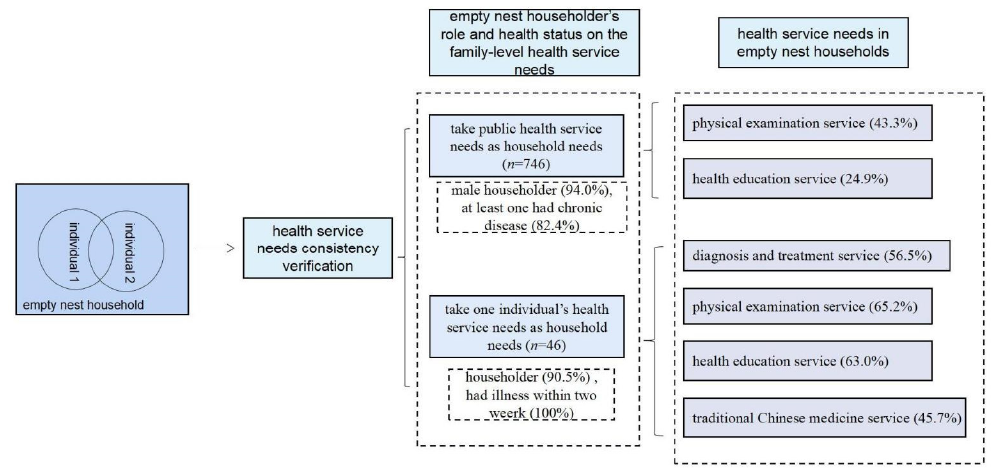
Figure 2. Health service needs in empty nest households